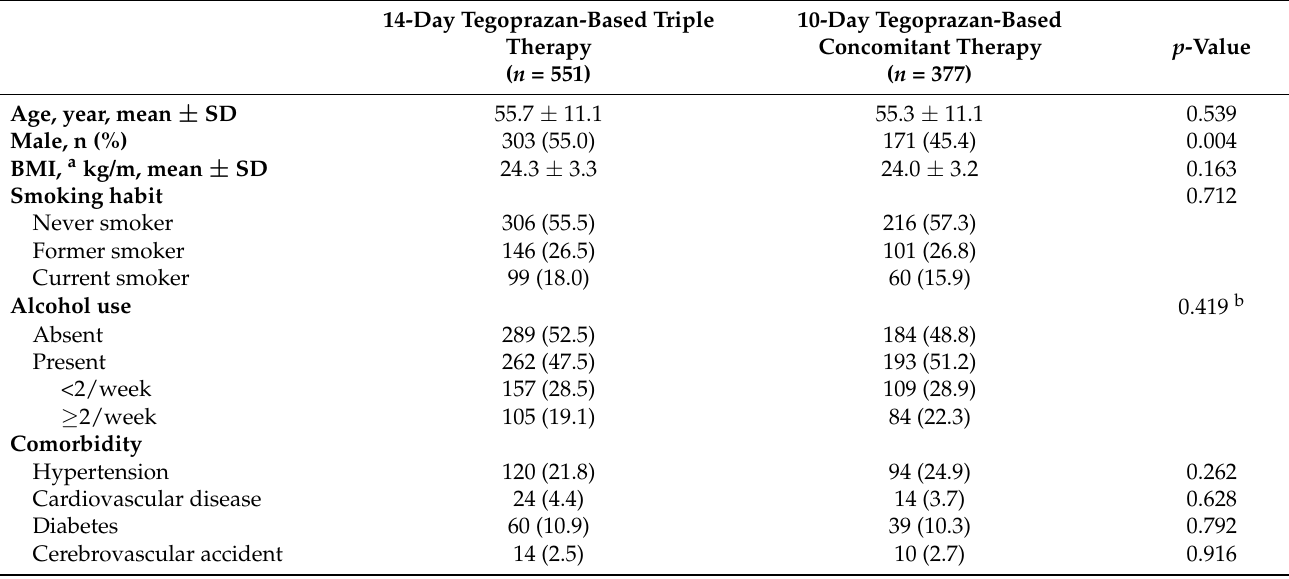
Table 1. Baseline characteristics of included